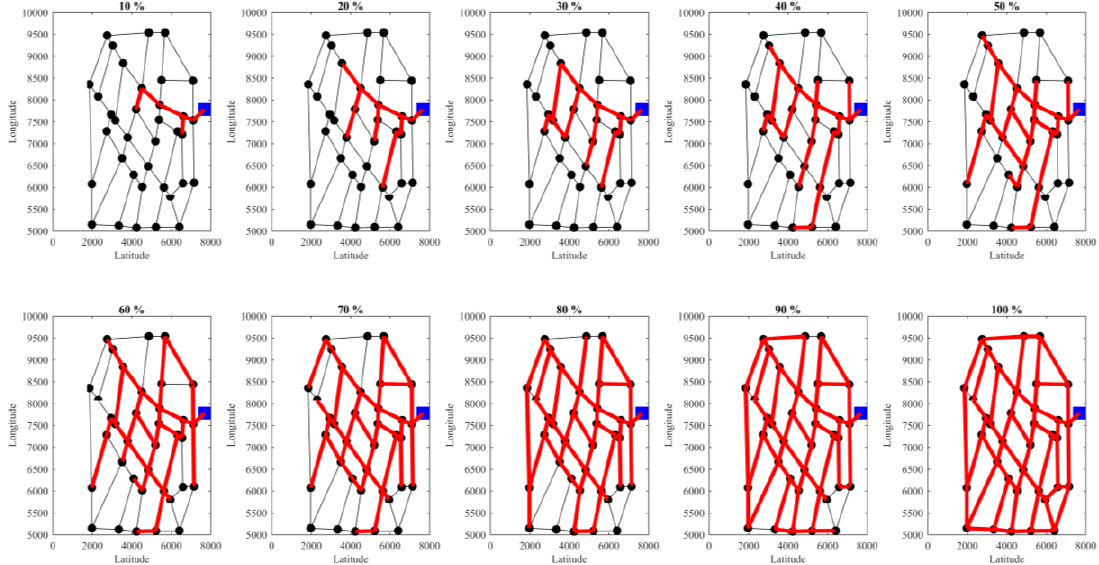
Figure 7. Scenarios for the TN size; red lines represent the TN and blue squares the water source.